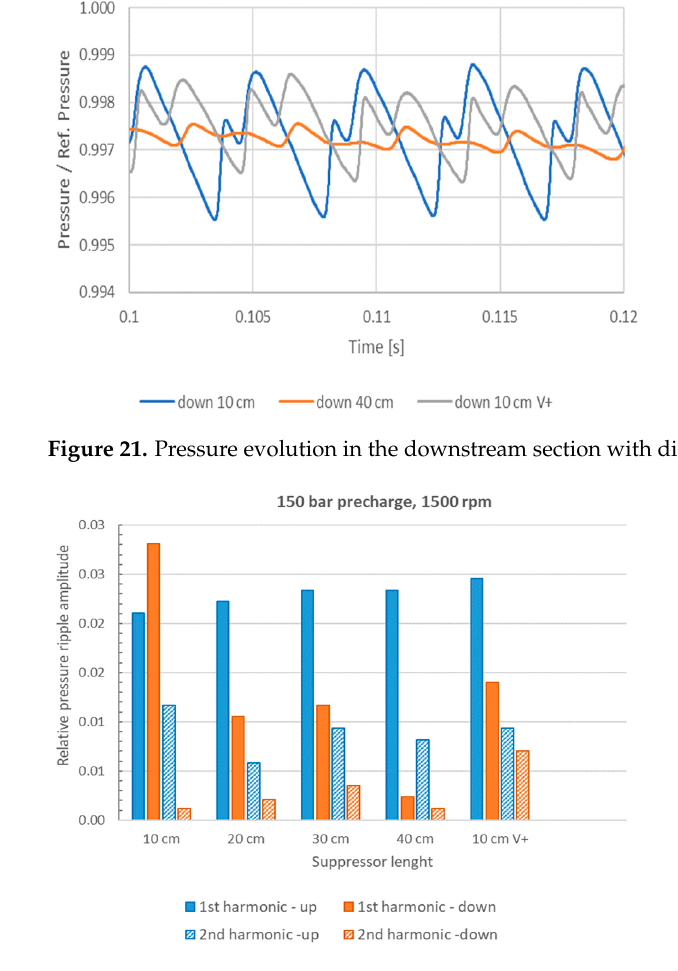
Figure 22. FFT of the pressure ripple for di ff erent damper lengths and gas volumes.